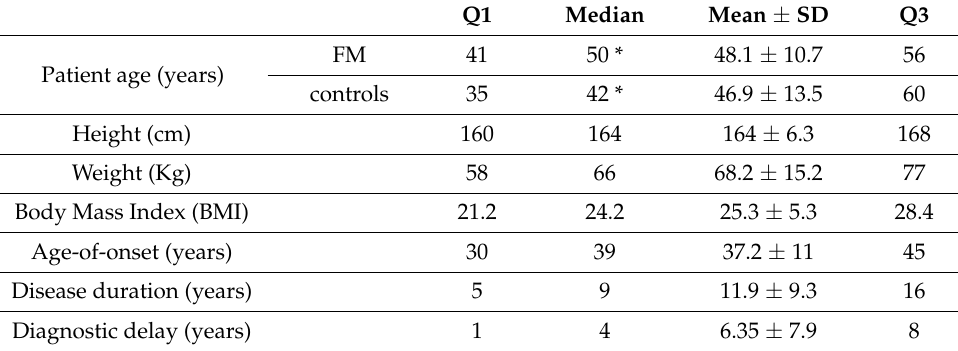
Table 2. Descriptive statistics of clinical features in Fibromyalgia (FM) participants ( n = 277) and of age in Controls ( n =